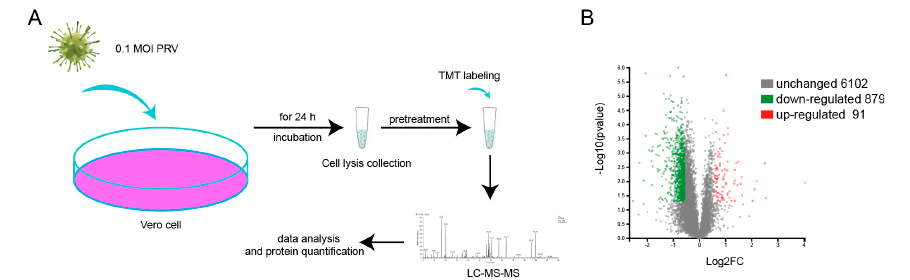
Figure 2. Overview of proteomic analysis procedure and DEPs. ( A ) The workflow of proteomic analysis. Vero cells were infected with 0.1 MOI PRV for 24 h and the whole cells lysis was collected after centrifugation at 12,000 rpm for 5 min. After reductive alkylation, the protein was labeled with TMT. Finally, the samples were subjected to liquid chromatography tandem mass spectrometry and bioinformatics analysis. ( B ) A total of 7022 proteins were identified, among which 89 proteins were markedly upregulated (red dots), 879 proteins were downregulated (green dots), and the remaining 6102 proteins stayed constant (gray dots). Proteins were considered significantly differently expressed when p value was less than 0.05 and fold change was less than 0.67 or more than 1.5 in this study. Table 2. Top 20 up ‐ regulated proteins.